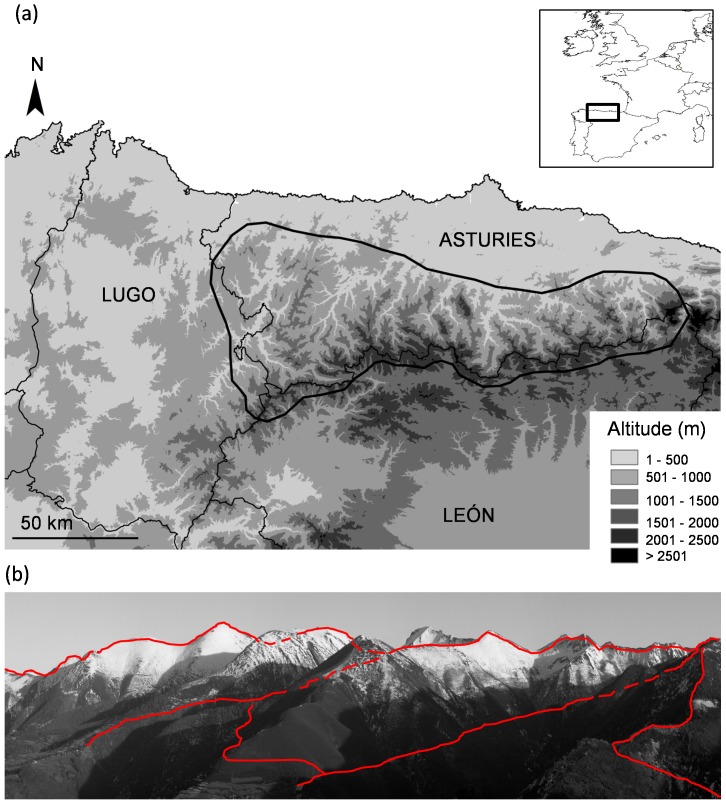
Study area and sampling design.(a) Map showing the study area located in the Cantabrian Mountains (N Spain). (b) Scheme showing the spatial distribution of transects within a typical sampling site.